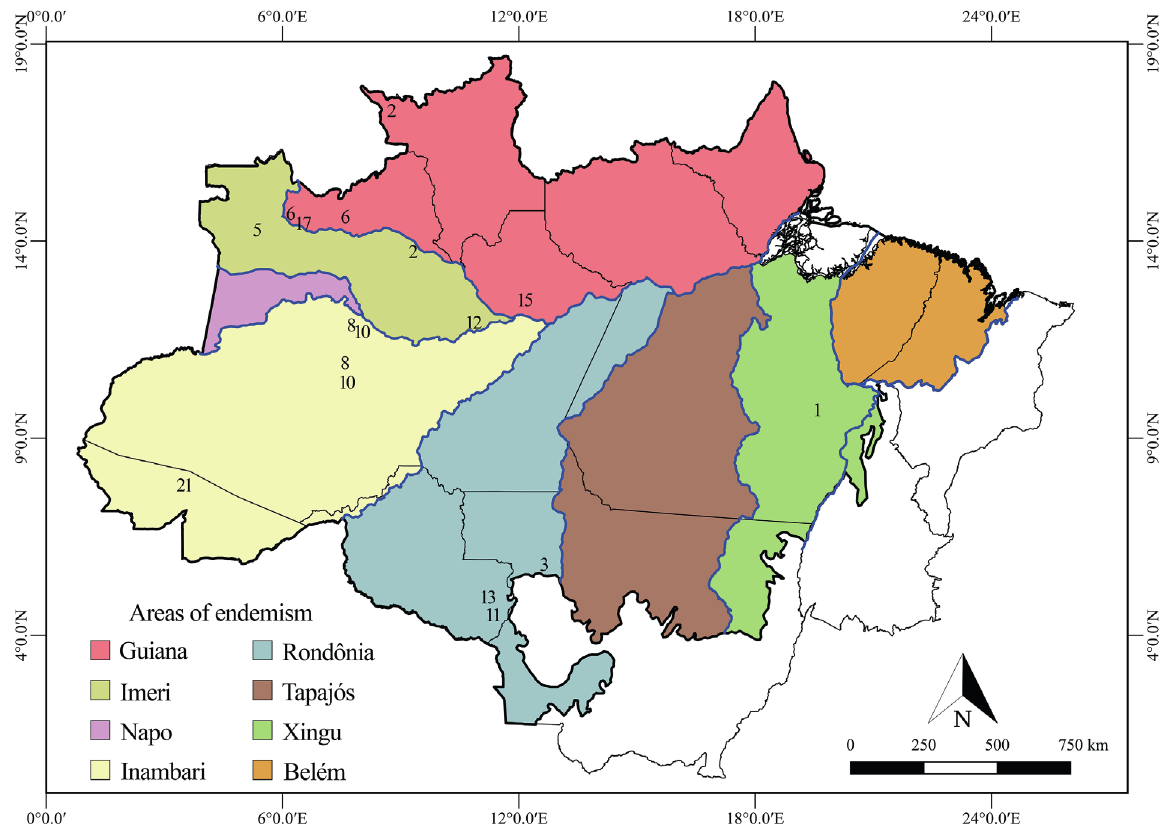
Figure 1. Brazilian Amazon map divided into areas of endemism according to Santos et al. (2005). Endemic species of the Brazilian Amazon bess beetles: 1. Passalus carajaensis , 2. P. fustigatus , 3. P. hylaius , 4. P. neivai , 5. P. nodifer , 6. Passipassalus brevicornis , 7 P . buhrnheimi , 8. P. corniculatus , 9. P . macrocerus , 10. P. manauensis , 11. P. uaupesensis , 12. Spasalus aquinoi , 13. S. elianae , 14. Veturius lepidus , (15) V. magdalenae and (16) V. urucuensis represent the lowest results th is study (Table SII).